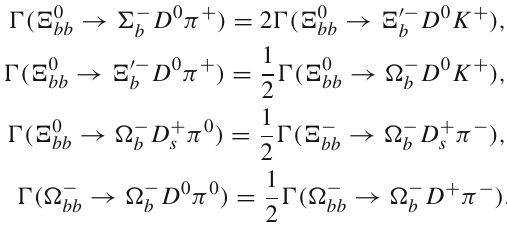
A.7: (cid:2) bb and (cid:5) bb decays into a bottom baryon, an anti-charmed meson and a light meson Channels involving an anti-triplet baryon